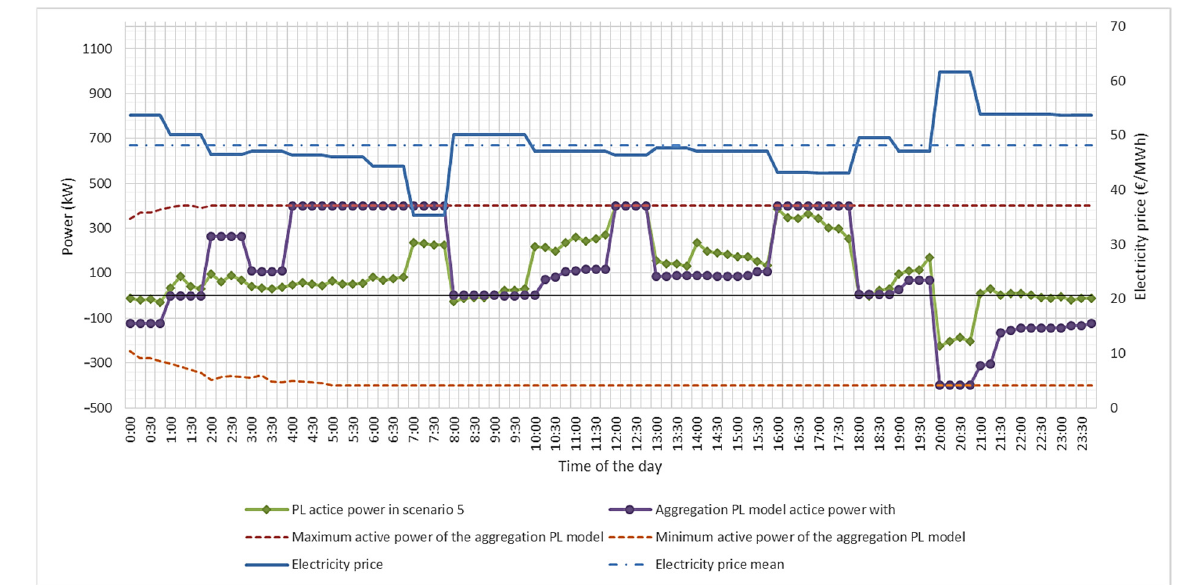
Figure 17. Electricity price and PL active power obtained by the aggregation model and compared with that obtained in scenario 5.